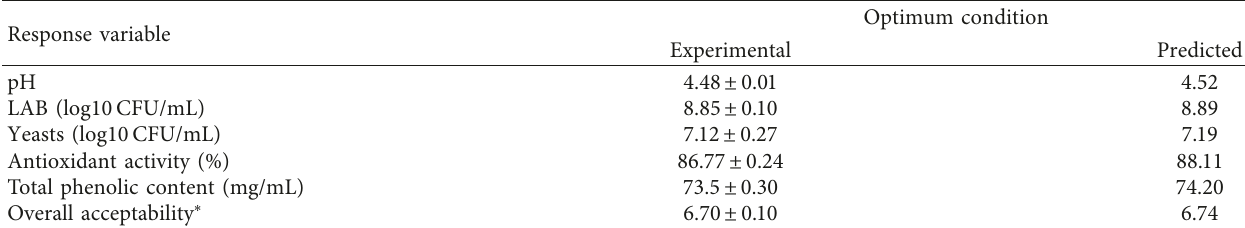
Figure 4: Response surface and contour plots that represent the effect of whey permeates and date syrup on overall acceptability score. Table 7: Predicted and experimental values of responses under optimum conditions.